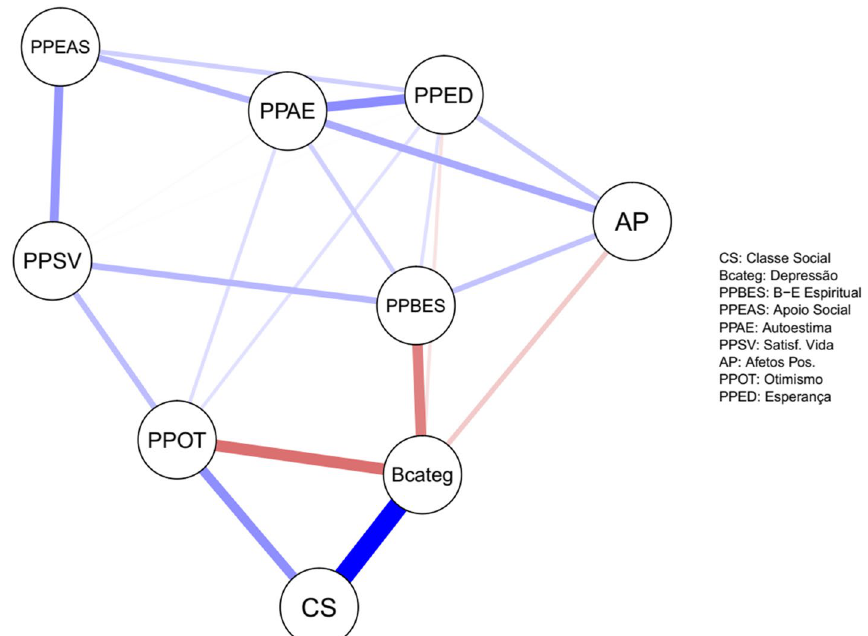
Fig. 1 Regularized partial network — Glasso method between Positive Psychology constructs and indicators of depression. CS, social class; Bcateg, depression scores; PPBES, spiritual well-being; PPEAS, social support; PPAE, self-esteem; PPSV, life satisfaction; AP, positive affects; PPOT, optimism; PPED, dispositional hope. The blue color assumed to be positive vs. red color negative relationship and the width of the lines (assumed to correspond to strength of the